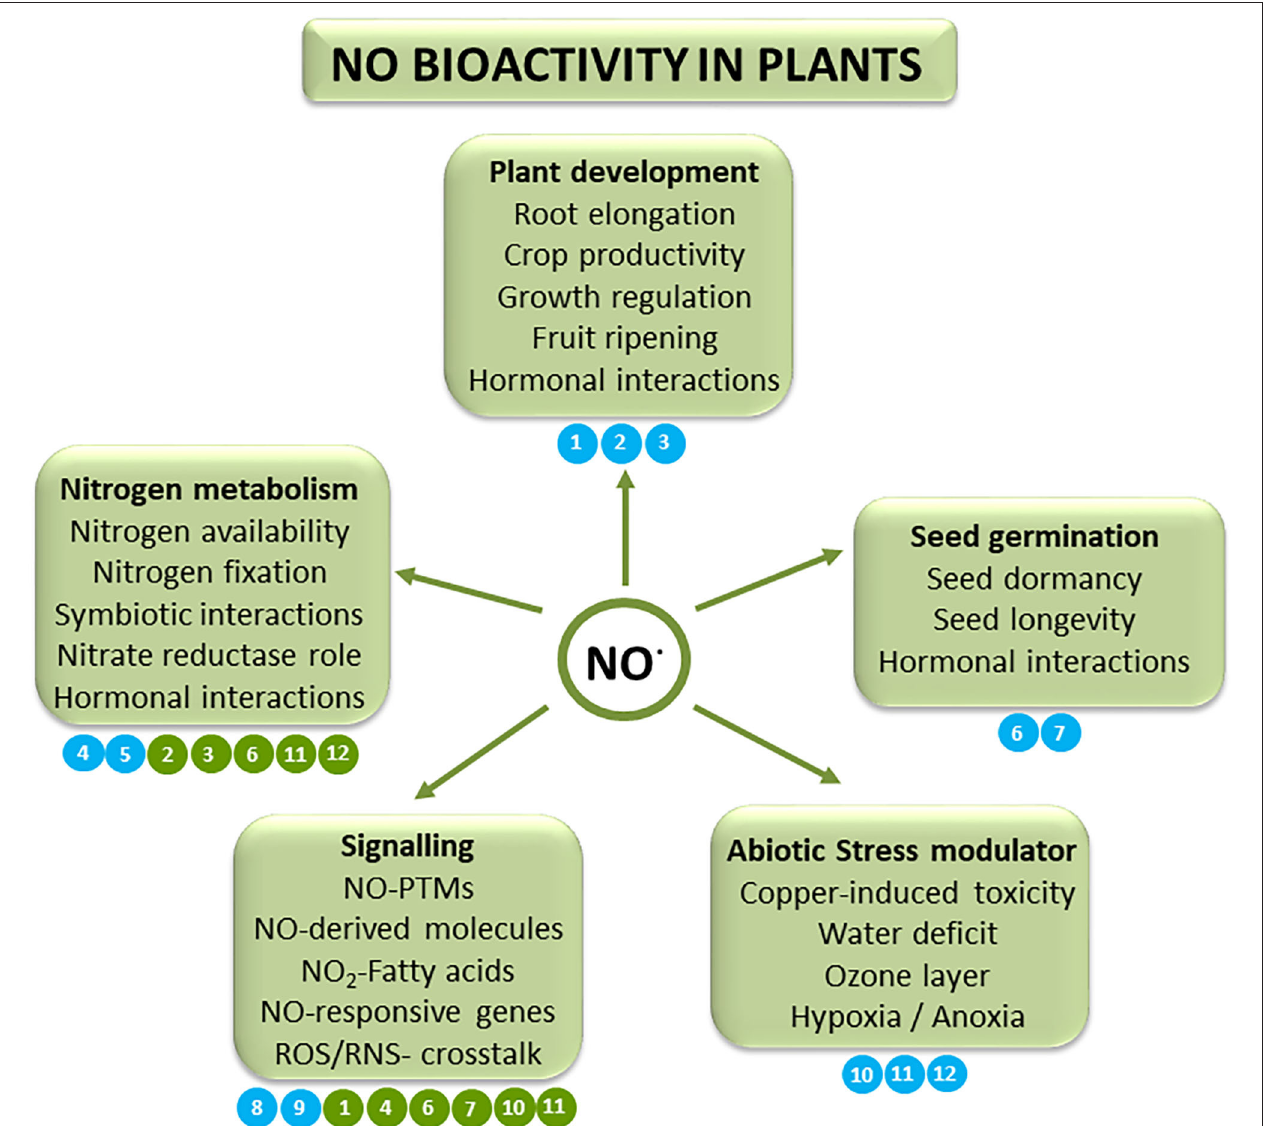
FIGURE 1 | Schematic model of the NO bioactivity in plants in the scope of plant development, seed germination, abiotic stress situations, signaling, and nitrogen metabolism. The numbers in blue indicate the main subject matter covered in each article in the Research Topic. Additionally, the numbers in green indicate the relationship to additional topics. [1] Oláh et al. [2] Nejamkin et al. [3] Li et al. [4] Signorelli et al. [5] Berger et al. [6] Wang et al. [7] Ciacka et al. [8] Mata-Pérez et al. [9] Nabi et al. [10] Rather et al. [11] Pissolato et al. [12] Timilsina et